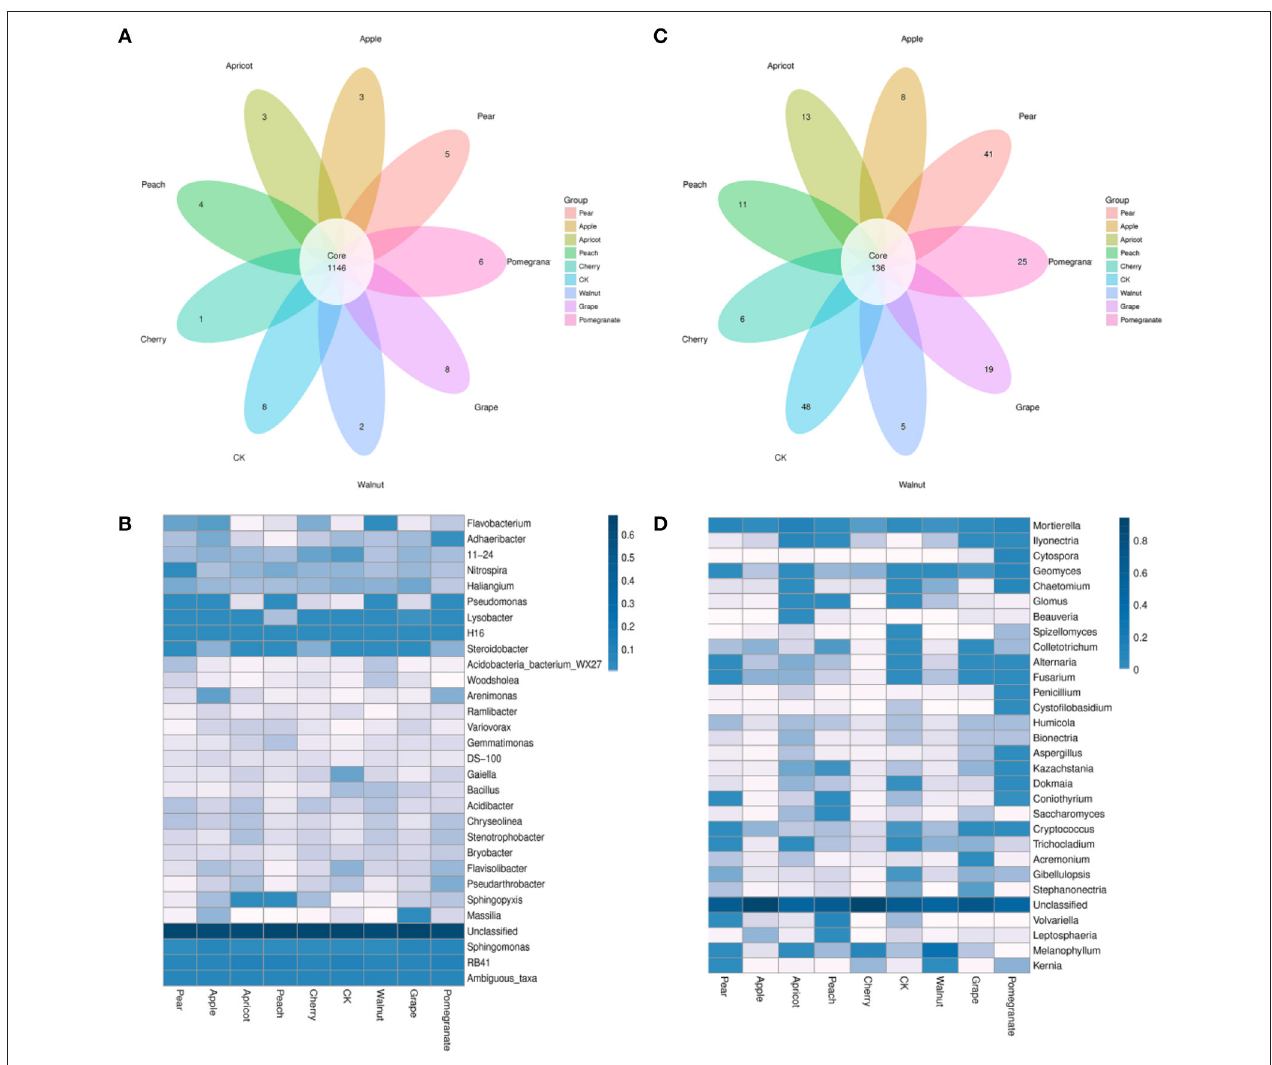
FIGURE 4 | Comparison of operational taxonomic units (OTUs) in the rhizosphere bacterial (A,B) and fungal (C,D) communities of different deciduous fruit trees. The Venn diagram depicts OTUs (97% sequence identity) that are shared or unique for different soil samples (A,C) . The heatmap illustrates the relative abundance of the top 30 bacterial and fungal genera (B,D) , and the scale bar shows the variation range of the normalized abundance of the bacterial community, indicating the differences in data among these trees. The left names are genera, and the color value of each square for each row indicates the relative abundance of genera.